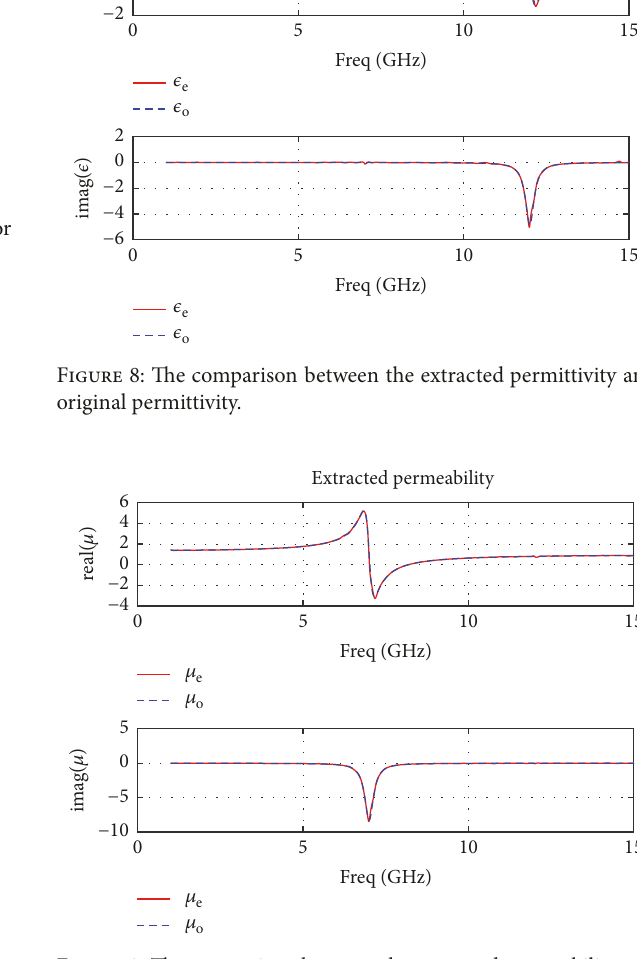
Figure 9: The comparison between the extracted permeability and original